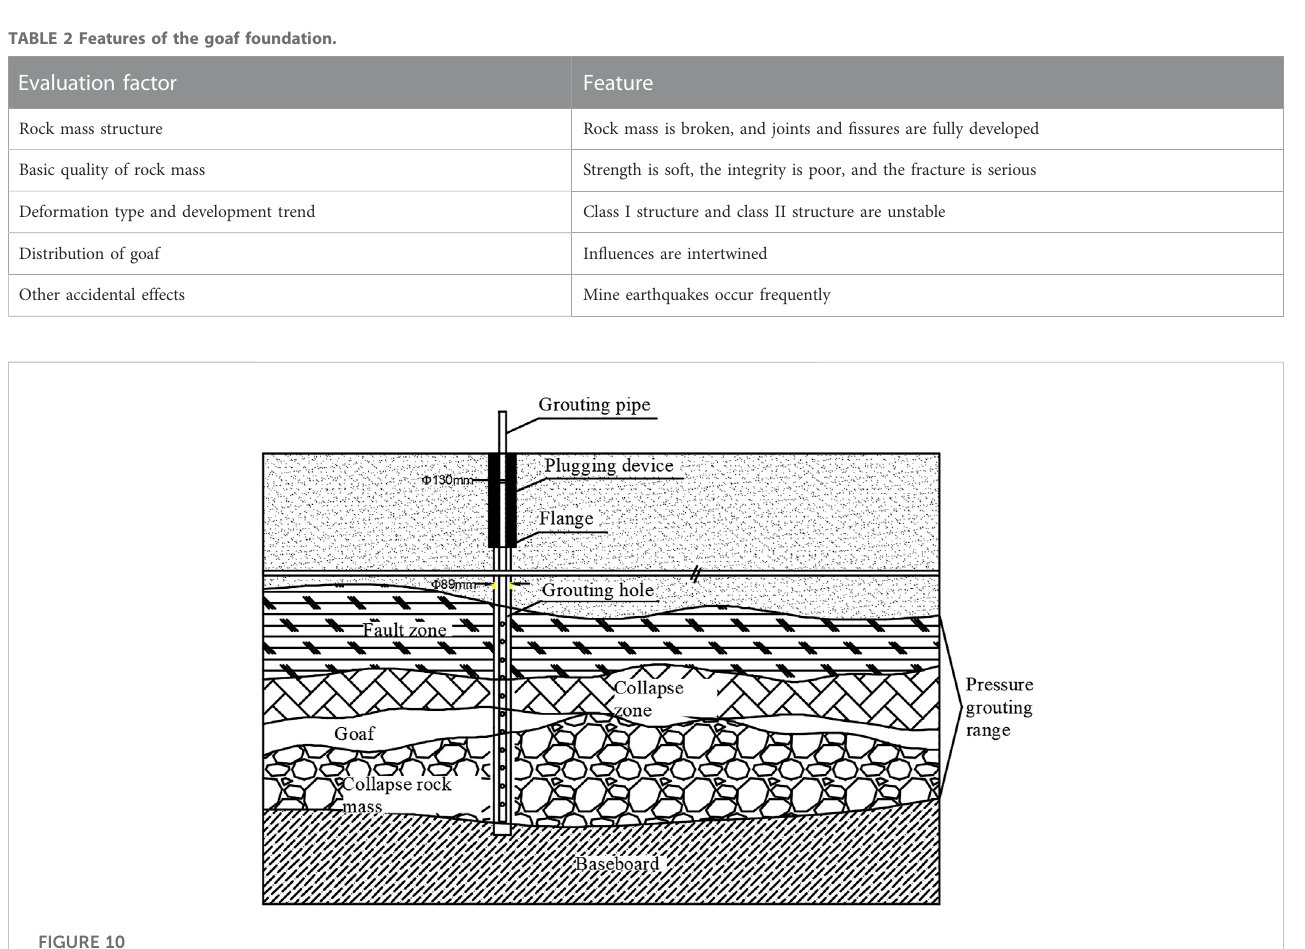
FIGURE 10 Schematic diagram of foundation grouting treatment in